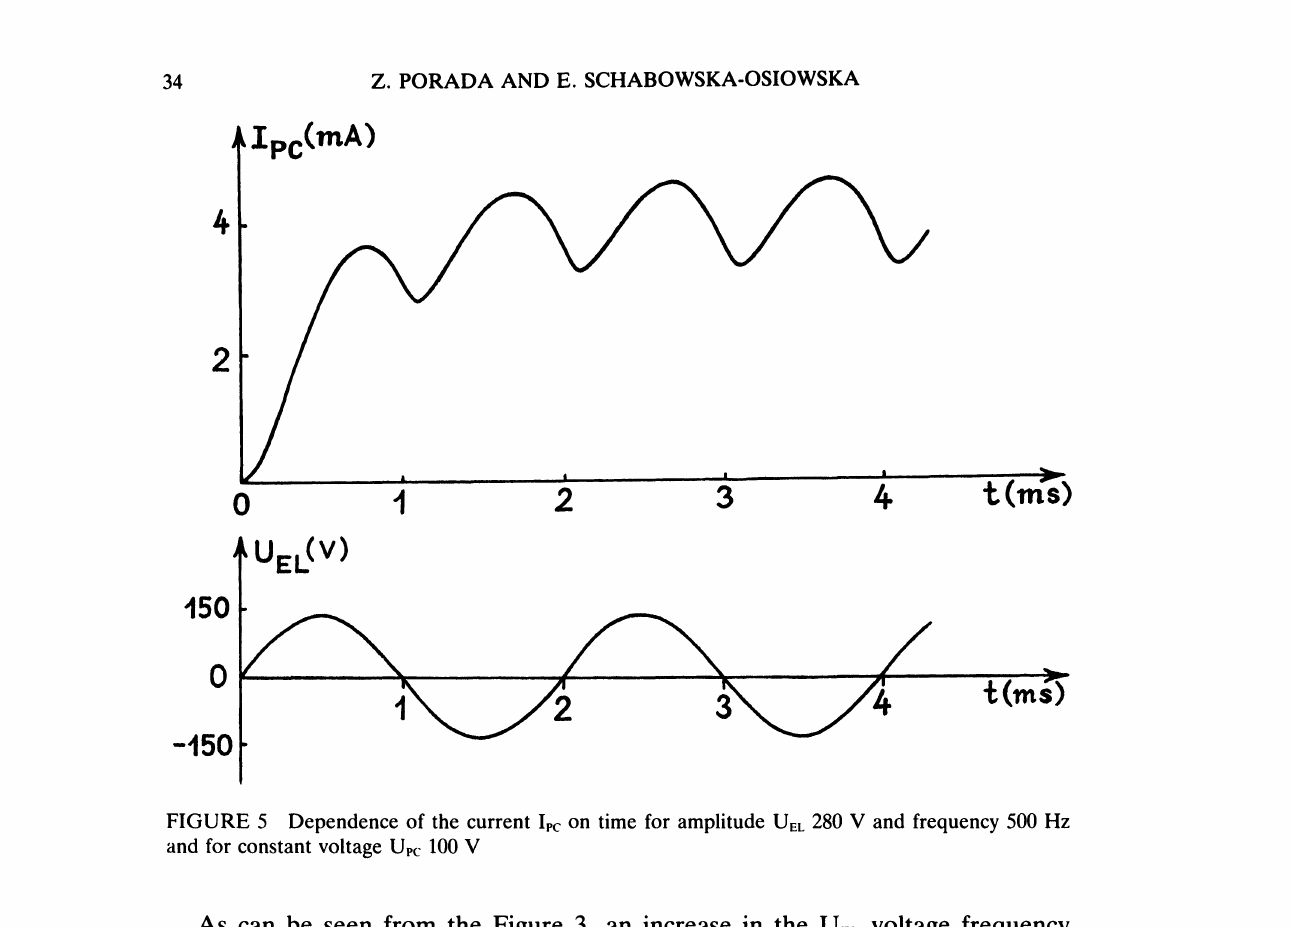
FIGURE 5 Dependence of the current Ipc on time for amplitude UEL 280 V and frequency 500 Hz and for constant voltage Upc 100